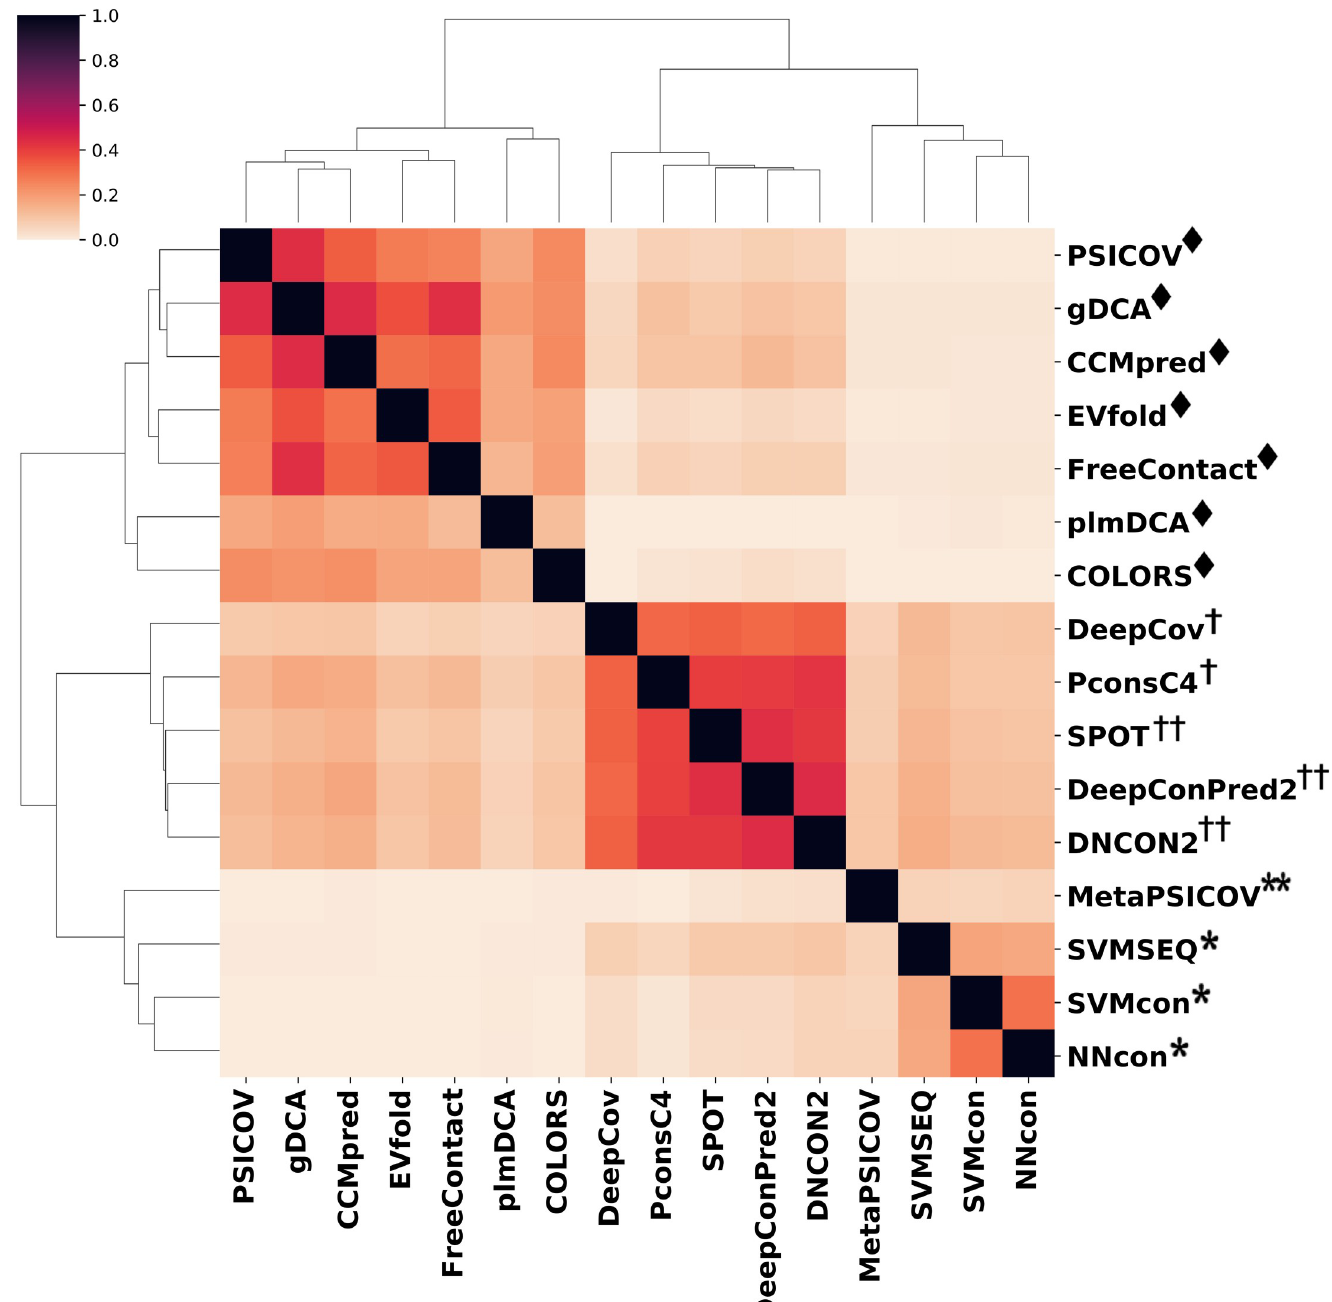
Fig 2. Jaccard index and evolutionary relationship between 16 predictors. The Jaccard indices are calculated using top L predicted contacts for each protein in TestSet1 and then averaged on the whole TestSet1. The clustering results indicate DL methods show stronger prediction similarity between each other than ML and ECA